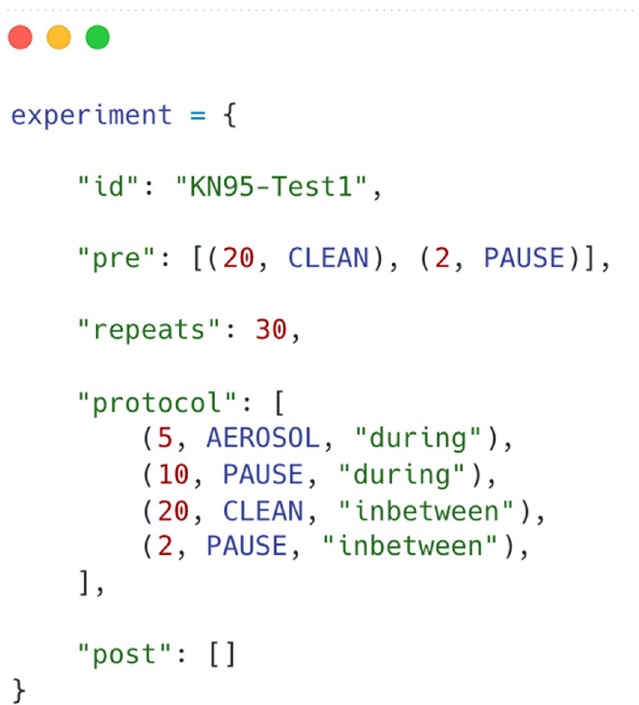
Figure 1. Schematic figure of a possible experimental setup. The figure shows four connected aerosol spectrometers (LAS), the controlling single-board computer (SBC), the custom printed circuit board (PCB), the aerosol generator, the air purifier, and a fan to create a uniform stream of aerosols.